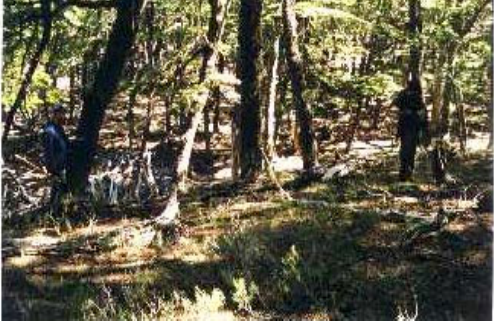
FIGURE 6 . Degraded Lenga